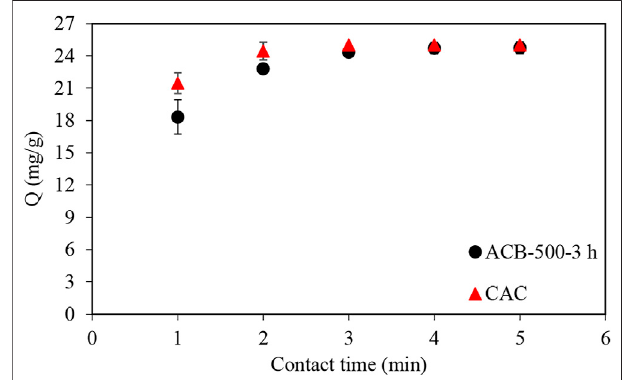
FIGURE 8 | Comparison of MB adsorption pro fi le using ACB-500-3 h sample and commercial activated carbon (CAC). 100 ml samples with 250 mg/L of MB concentration to which 1 g ofbio-char and CAC was